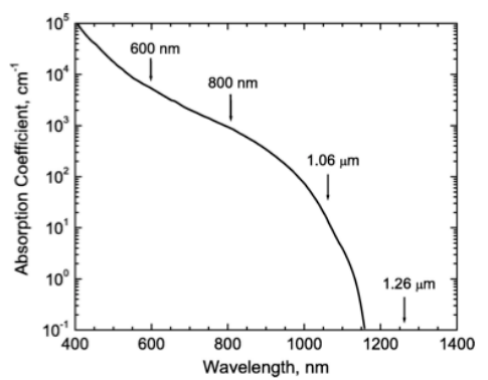
Figure 2. Absorption coefficients of light at different wavelengths in silicon.